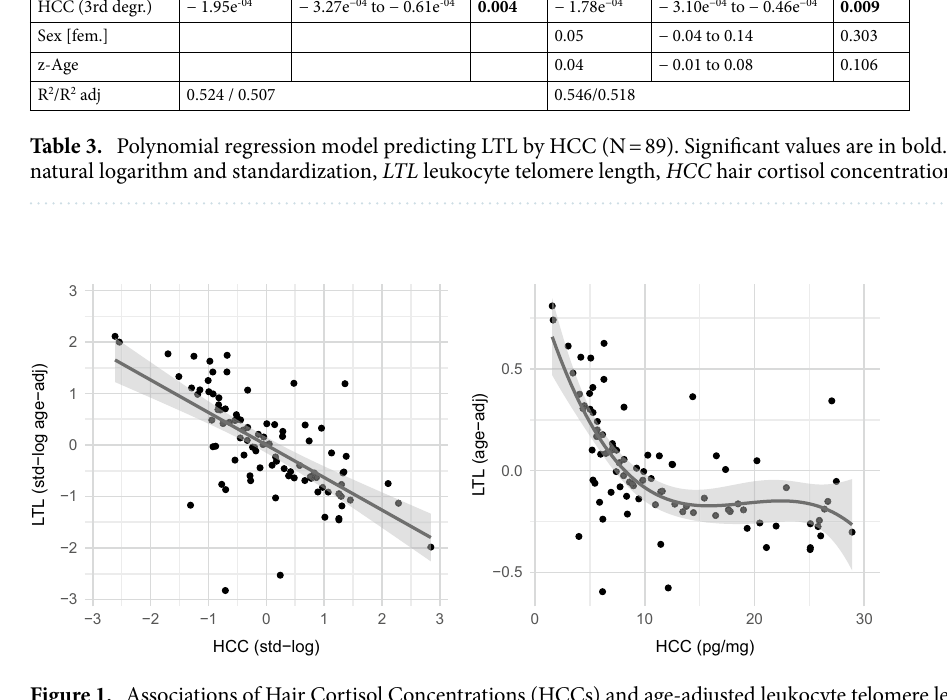
Figure 1. Associations of Hair Cortisol Concentrations (HCCs) and age-adjusted leukocyte telomere length (LTL) in a high-risk sample of young adults: (Left) Scatterplot of log-transformed and standardized age-adjusted LTL and log-transformed and standardized HCC, the regression line corresponds to a linear model displaying the association between HCC and LTL; (Right) Scatterplot of age-adjusted LTL and HCC, the regression line corresponds to a polynomial linear model of third order displaying the association between skewed HCC and